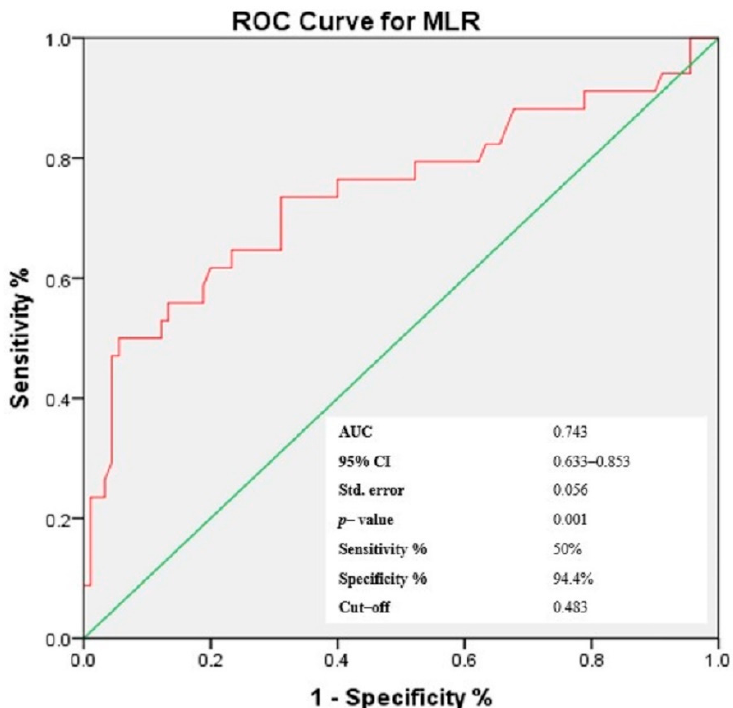
Figure 4. Receiver operating characteristic curve of MLR levels for the prediction of the cutaneous vasculitis lesions in patients with pSS.